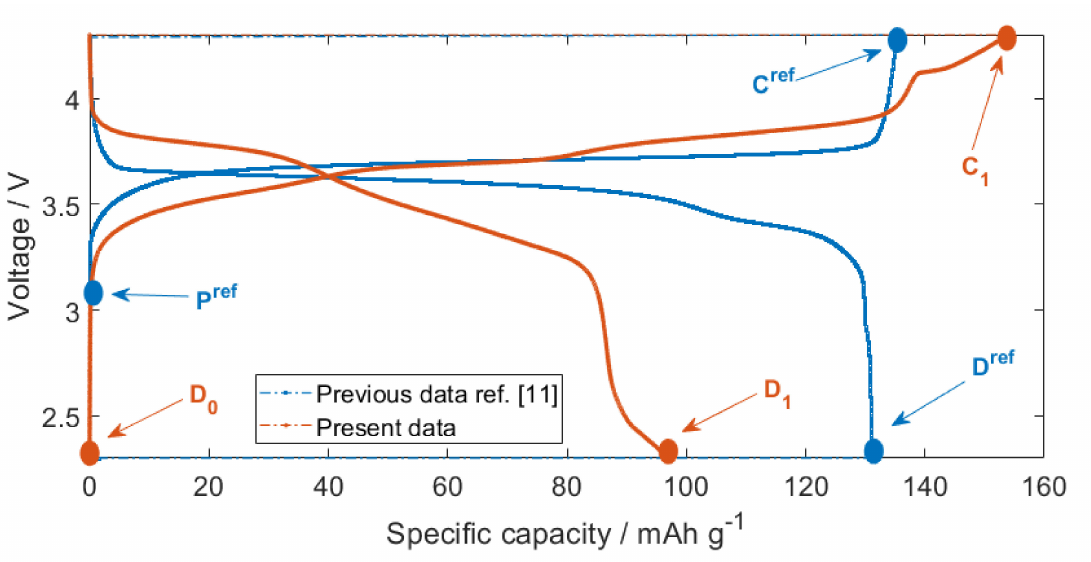
Figure 1. Voltage profiles upon galvanostatic charge-discharge of a manganese hexacyanoferrate (MnHCF) electrode subjected to anomalous pre-cycling (red curve). For comparison, the behavior of a pristine electrode (data from ref. [11]) is also shown (blue curve). Also shown is the labeling of a few selected states of charge (see text).